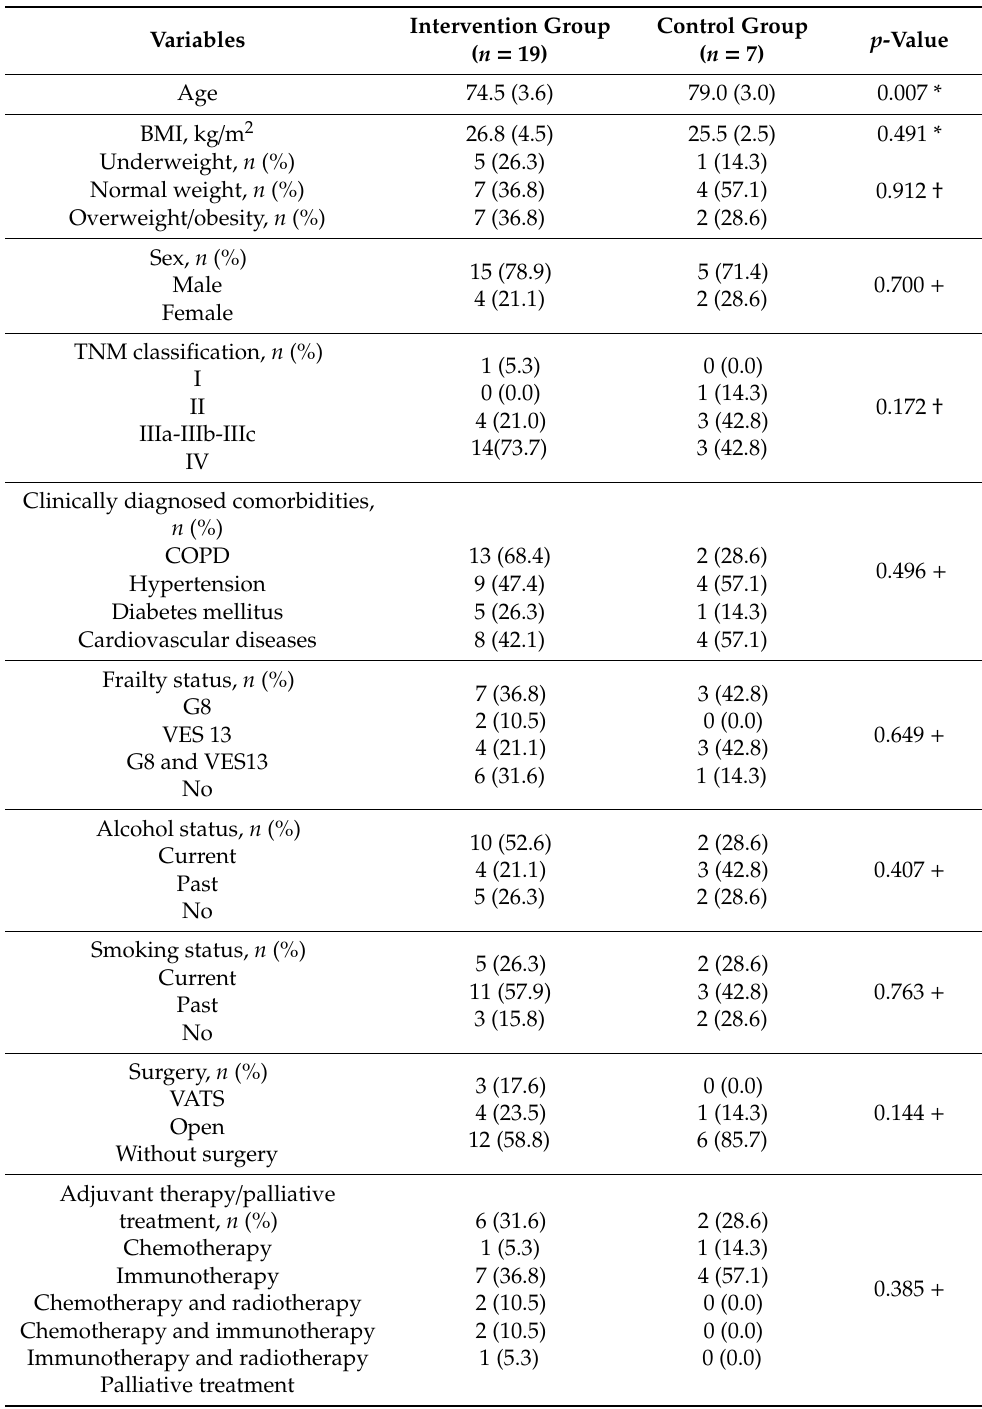
Table 2. Baseline characteristics of the